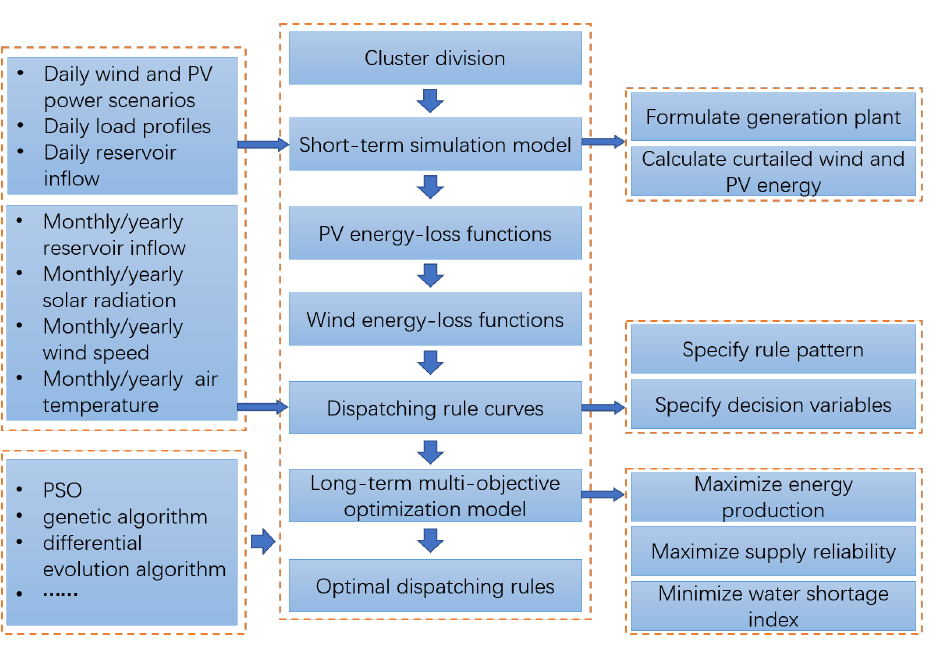
Figure 9. Dispatching rules for the hydro-wind-solar hybrid